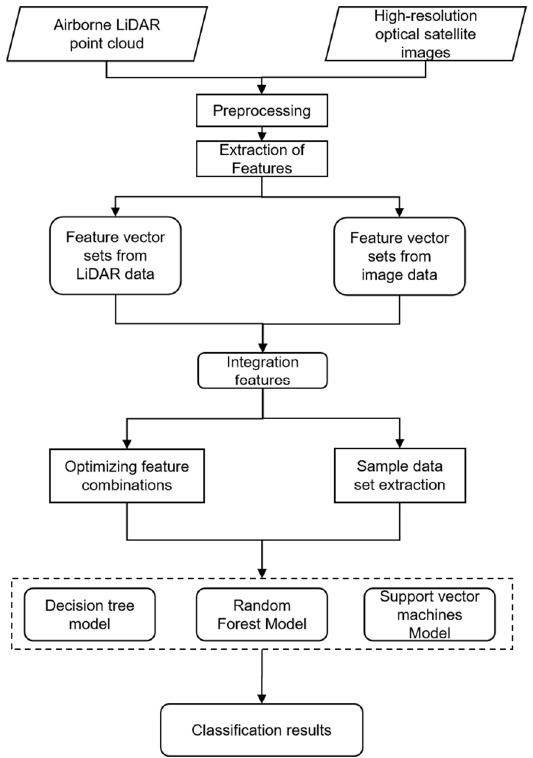
Figure 1. Flowchart of research method.